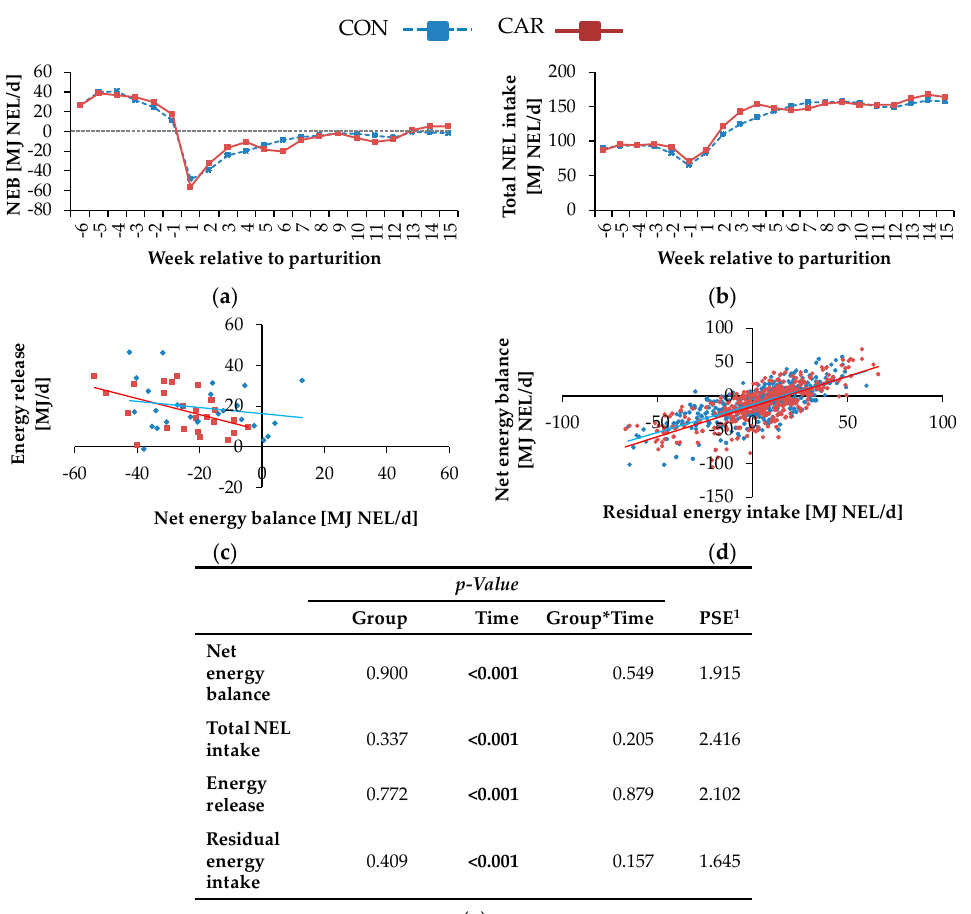
Figure 3. ( a ) Net energy balance (NEB), ( b ) total NEL intake of cows fed a non-supplemented (CON) or an L-carnitine-supplemented diet (25 g/d from 6 weeks ap up to week 15 pp , CAR), ( c ) regression of energy release from adipose tissue in dependence on net energy balance in the first six weeks of lactation. ( y CON = − 0.15 p > 0.05 x + 16.25, r 2 = 0.041; y CAR = − 0.40 p < 0.05 x + 8.00, r 2 = 0.229; slopes were not significantly different ( p > 0.05)), ( d ) and regression of net energy balance in dependence on residual energy intake from the first week until week 15 of lactation ( y CON = 0.82 p < 0.05 x − 12.88, r 2 = 0.549; y CAR = 0.89 p < 0.05 x − 15.67, r 2 = 0.548); the slopes between CON and CAR were not significantly different ( p >